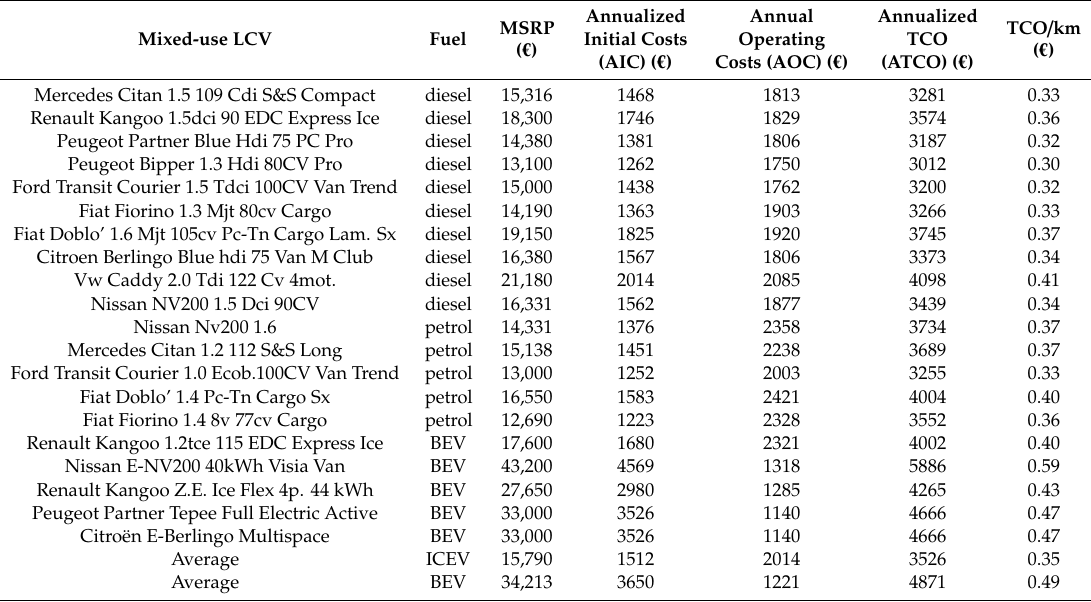
Table 7. Estimates for mixed-use LCVs: baseline